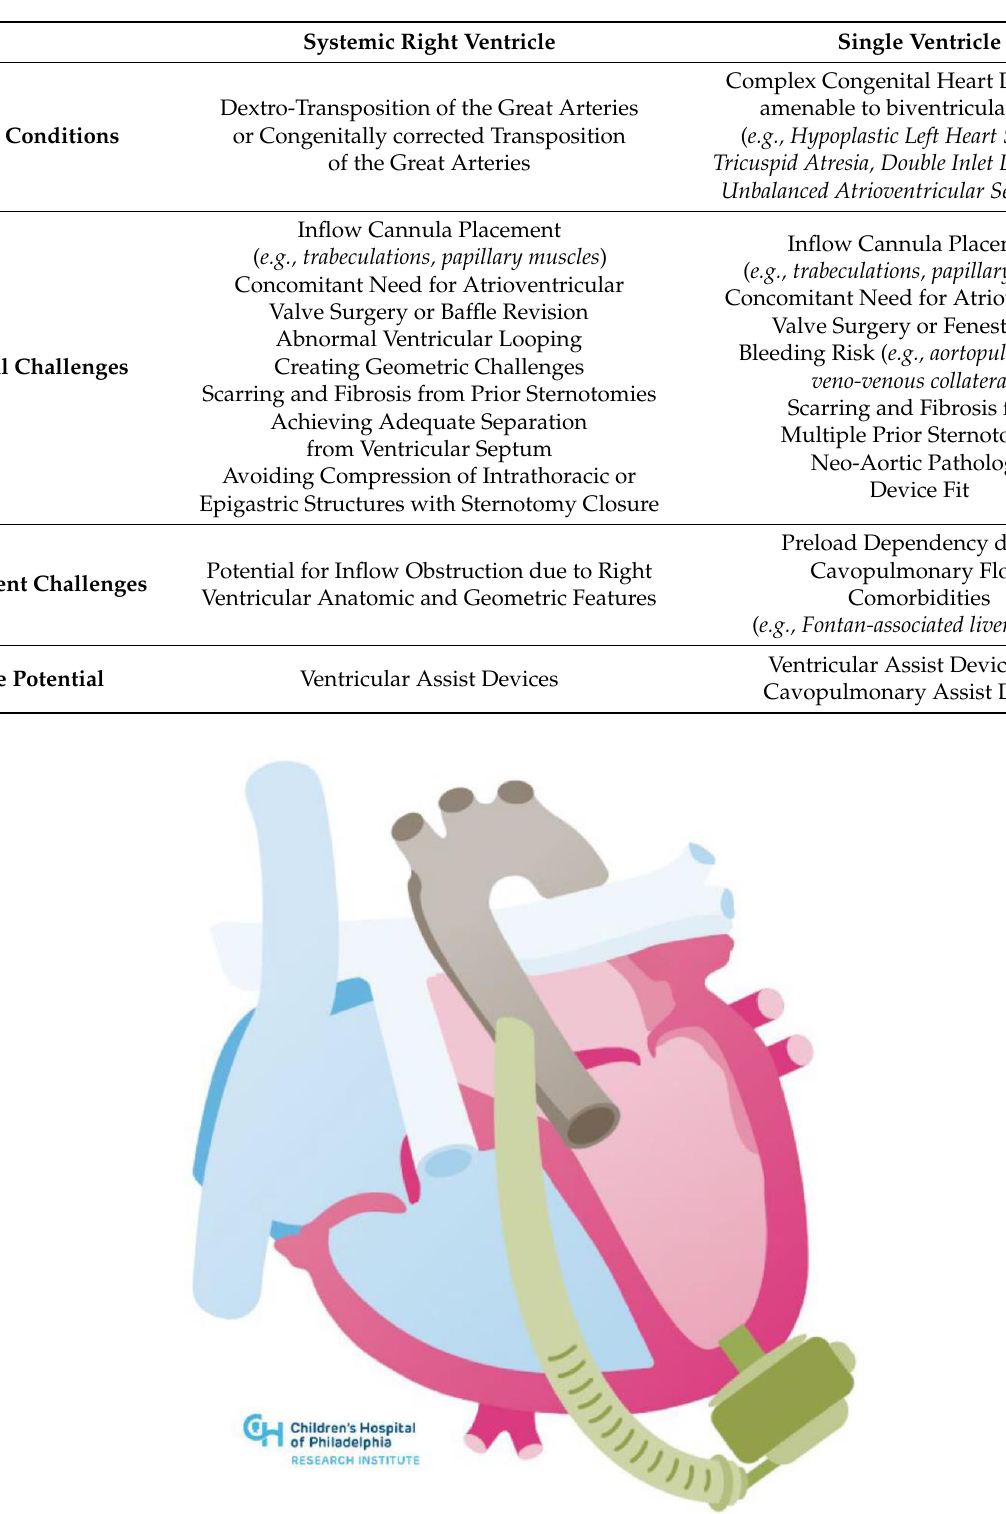
Table 1. Summary of Key Considerations for Durable Mechanical Circulatory Support in the Systemic Right and Single Ventricle.